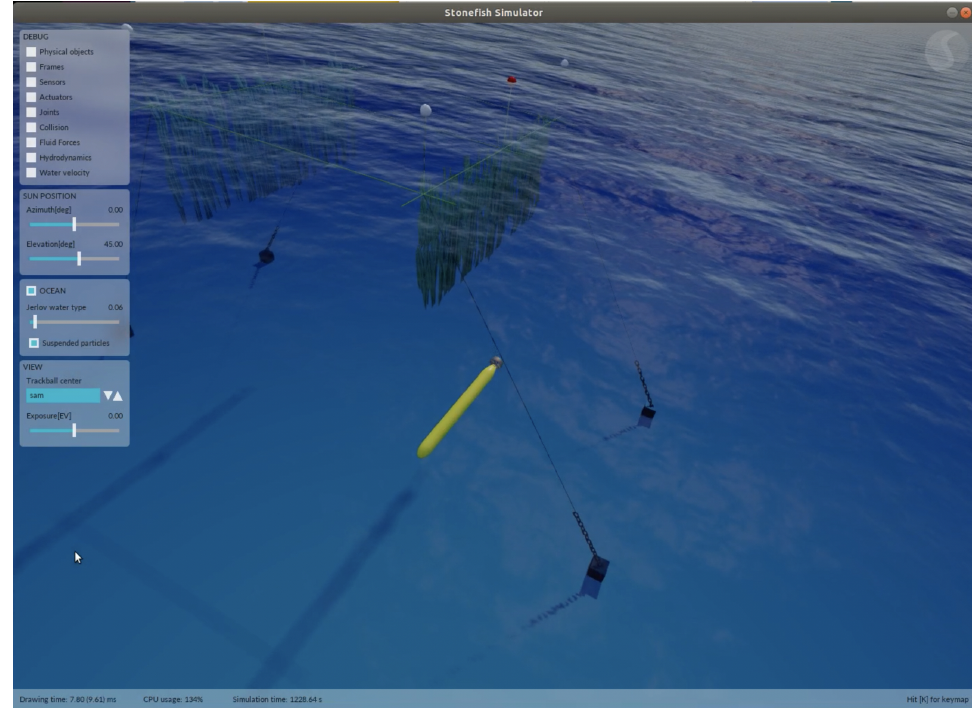
Figure 11. View of the AUV SAM operational in the simulated seaweed farm.